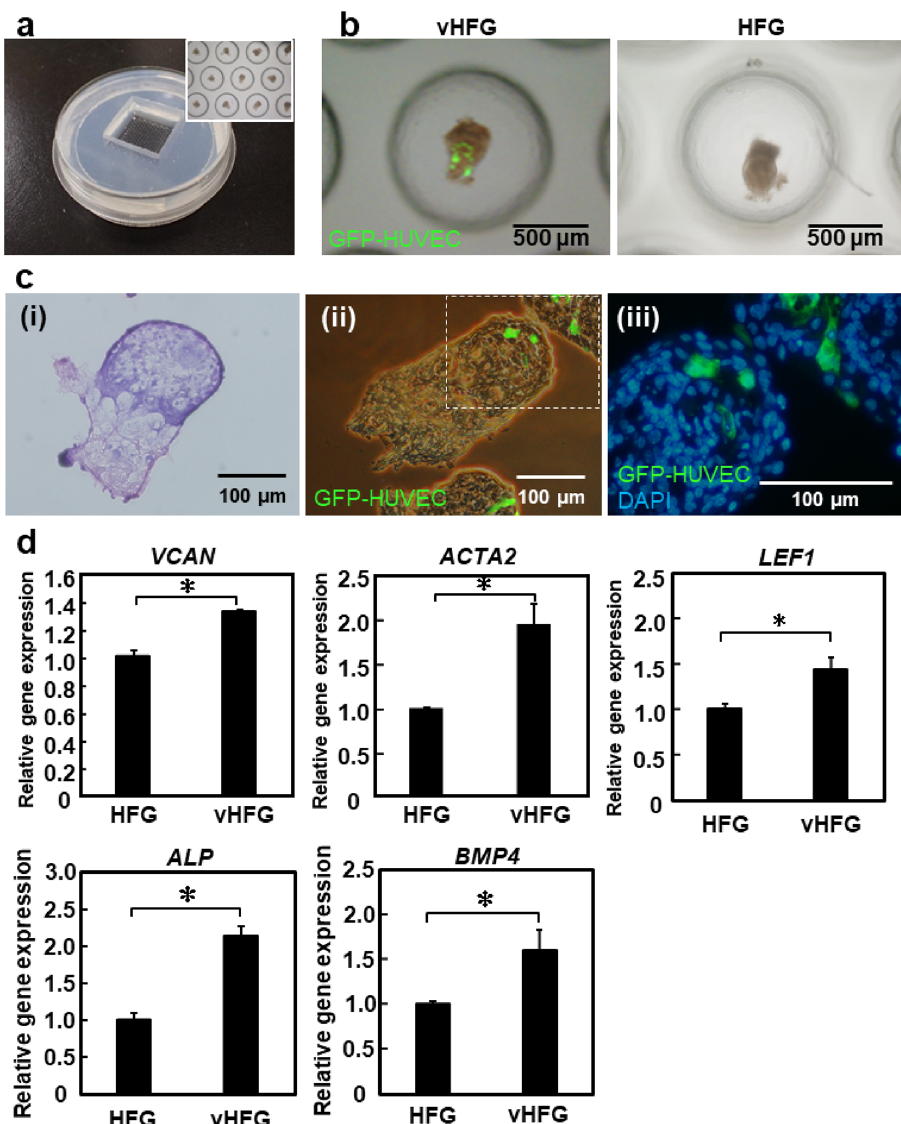
Figure 3. vHFG preparation in HFG chip. ( a ) Fabricated HFG chip. The inset shows a magnified view of vHFGs in microwells. ( b ) Representative appearance of vHFGs and HFGs after 3 days of culture in the HFG chip. The number of cells seeded in the HFG chip was 1.13 × 10 6 total cells/chip for vHFG and 1 × 10 6 total cells/ chip for HFG. GFP-HUVECs were visualized, and fluorescence and phase-contrast images were overlaid for vHFG. ( c ) HE-staining (i) and fluorescence staining (ii, iii) of cross-sections of vHFGs after 3 days of culture in the HFG chip. GFP-HUVECs (green) and nuclei (blue) were visualized. ( d ) Relative expression of trichogenic genes. GAPDH was used as a reference gene to normalize expression. Error bars represent the standard error of mean calculated from three independent experiments for each condition. Variables were statistically evaluated using Student’s t -test. * p < 0.05 was considered